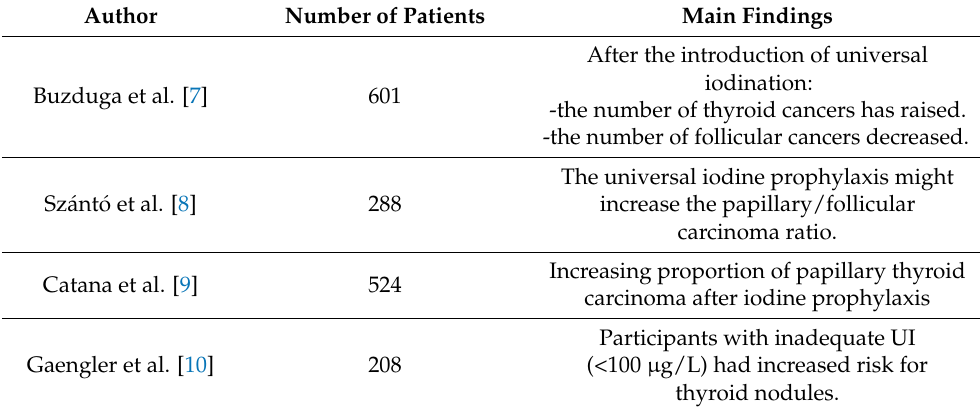
Table 2. Main findings from the case studies on iodine deficiency related to thyroid carcinoma in Romania.